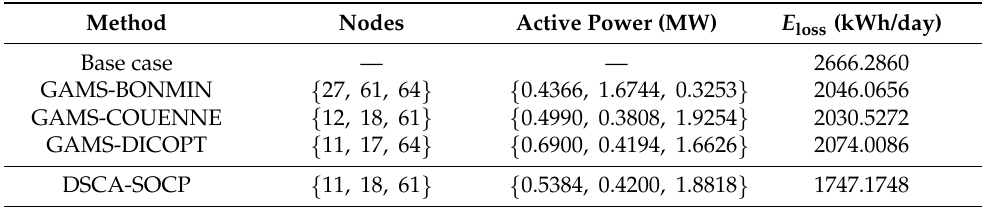
Figure 6. Daily behavior of the demand and solar photovoltaic generation. Table 6. Optimal location and sizing of the DGs considering variable power factor capabilities in the 33-node test